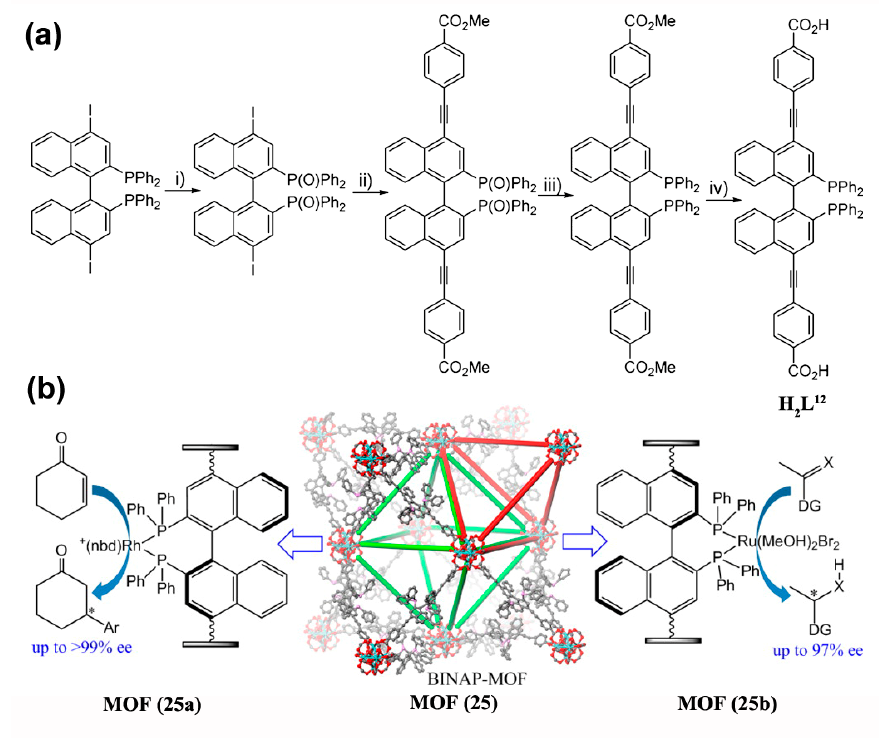
Figure 11. ( a ) Synthesis of the ligand H 2 L 12 . ( b ) Synthesis of homochiral MOFs by post-synthetic metalation of 25a and 25b and their applications in asymmetric catalysis. Reproduced from [89] with permission from the American Chemical Society.